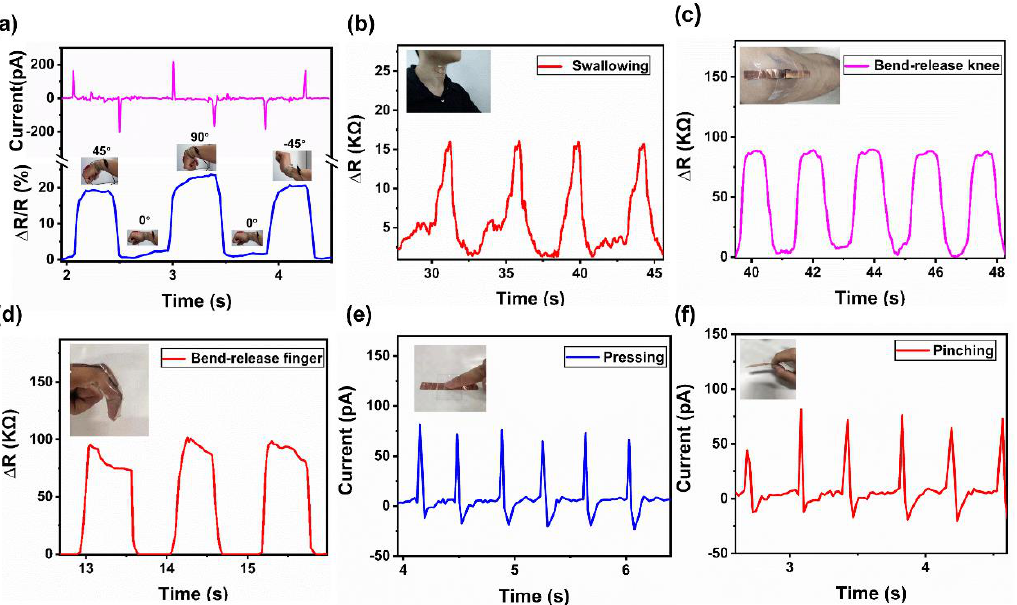
Figure 9. Practical applications of the PMR dual-mode flexible sensor for electronic skin. ( a ) Sensing response of the flexible sensor for detecting wrist bending and release. ( b ) Sensing response of the flexible sensor for swallowing action. ( c ) Sensing response of the flexible sensor for bending and straightening of the knee. ( d ) Sensing response of the flexible sensor for bending and releasing with a finger. ( e ) Piezoelectric signal with quick finger press. ( f ) Piezoelectric signal with finger rapid pinching.